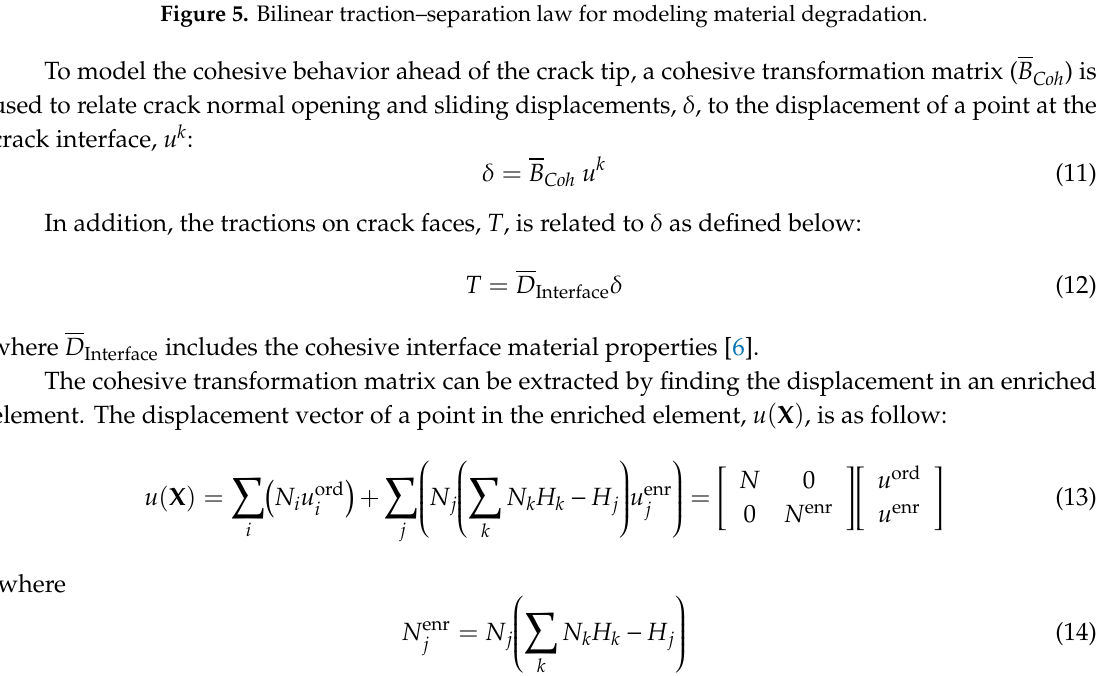
Figure 5. Bilinear traction–separation law for modeling material degradation.